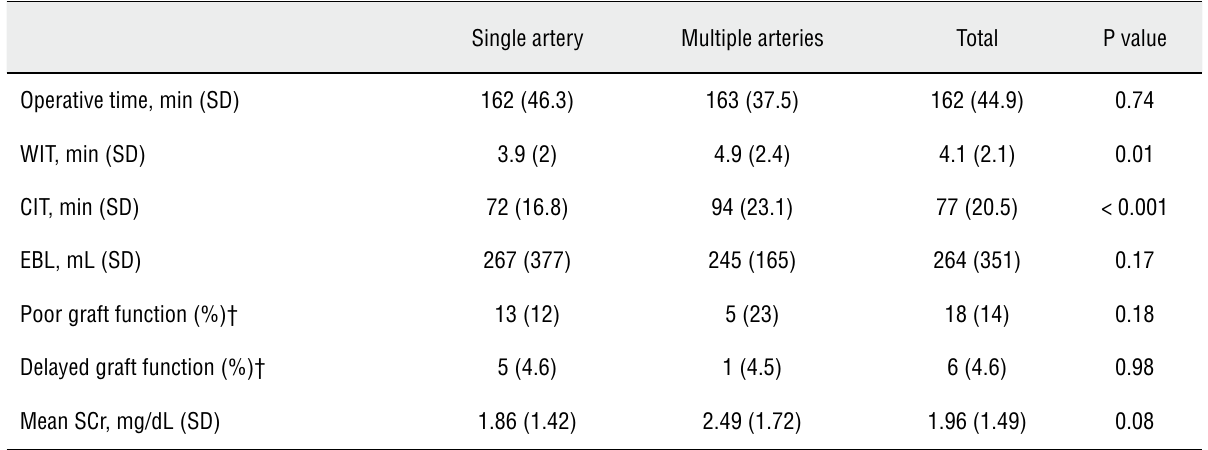
Table 2 - Operative and early function data for both groups.